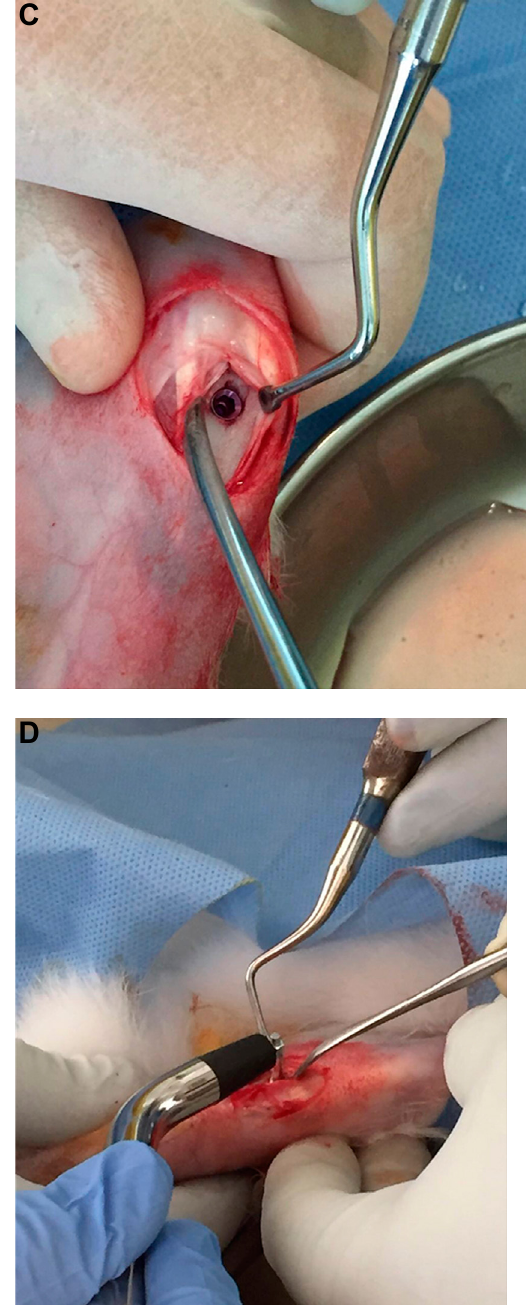
Figure 1A-D - Intraoperative photographs showing implant placement in the tibial methaphysis region of the rabbits, and Resonance Frequency Analysis (RFA). A: exposure of the anterior surface of the tibial bone via linear incision; B: photograph of the implant before placement; C: surgical area after the implant’s placement; D: photograph of Resonance Frequency